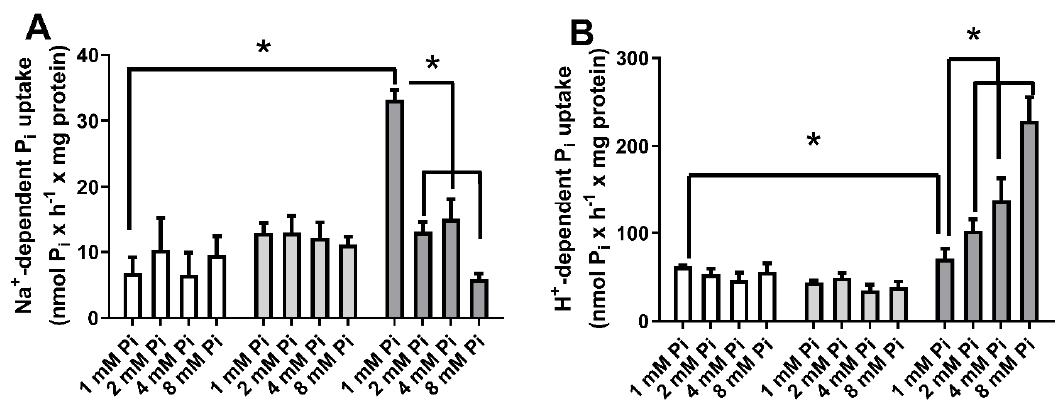
Figure 1. Effect of high inorganic phosphate concentrations on Na + -dependent or H + -dependent Pi uptake in breast cell lines. Different breast cell lines: MCF10-A (blank bars), MCF-7 (grey bars), and MDA-MB-231 (dark grey bars) were treated with various Pi concentrations (1, 2, 4 or 8 mM Pi) for 24 h. Na + -dependent ( A ) or H + -dependent ( B ) Pi uptake was measured for 1 h, as described in Section 4. Bars represent mean ± SE of at least three independent biological samples. * p < 0.05 indicates changes were significantly different, as assessed by ANOVA followed by Tukey’s multiple comparison test.